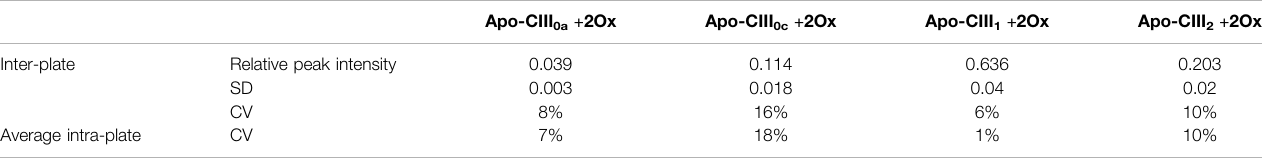
TABLE 1 | Inter- and intra-plate variability. Relative peak intensities, standard deviation (SD) and coef fi cient of variation (CV) are given for the intra- and inter-plate variability based on 136 plasma standards.